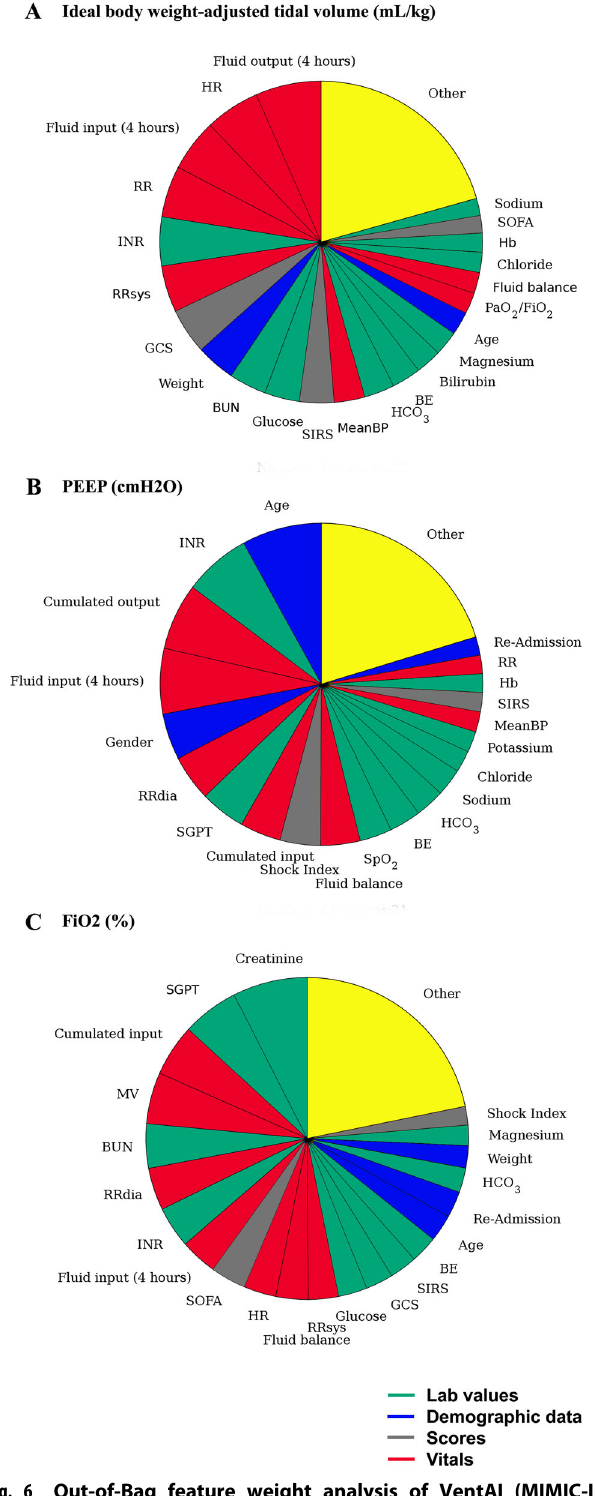
Fig. 6 Out-of-Bag feature weight analysis of VentAI (MIMIC-III dataset). Relative weight of each feature using out-of-bag feature weight analysis, based on the relative loss of prediction, represented by an increase of the mean squared error. a Ideal body weight-adjusted tidal volume (mL/kg). b PEEP (cmH 2 0). c FiO 2